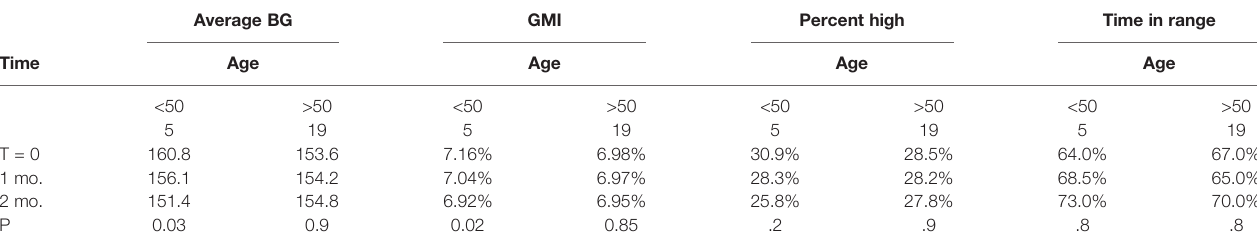
TABLE 2 | Blood sugar, GMI, Percent High and Percent Time in Range in those < 50 and > 50 years old.